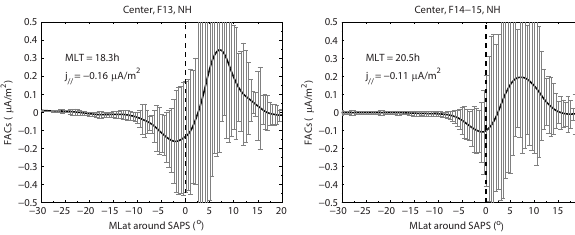
Figure 8. Superposed epoch analysis of FACs centering around F13 and F14/15 SAPS within ± 0 . 5h MLT, almost concurrent with SAPS.